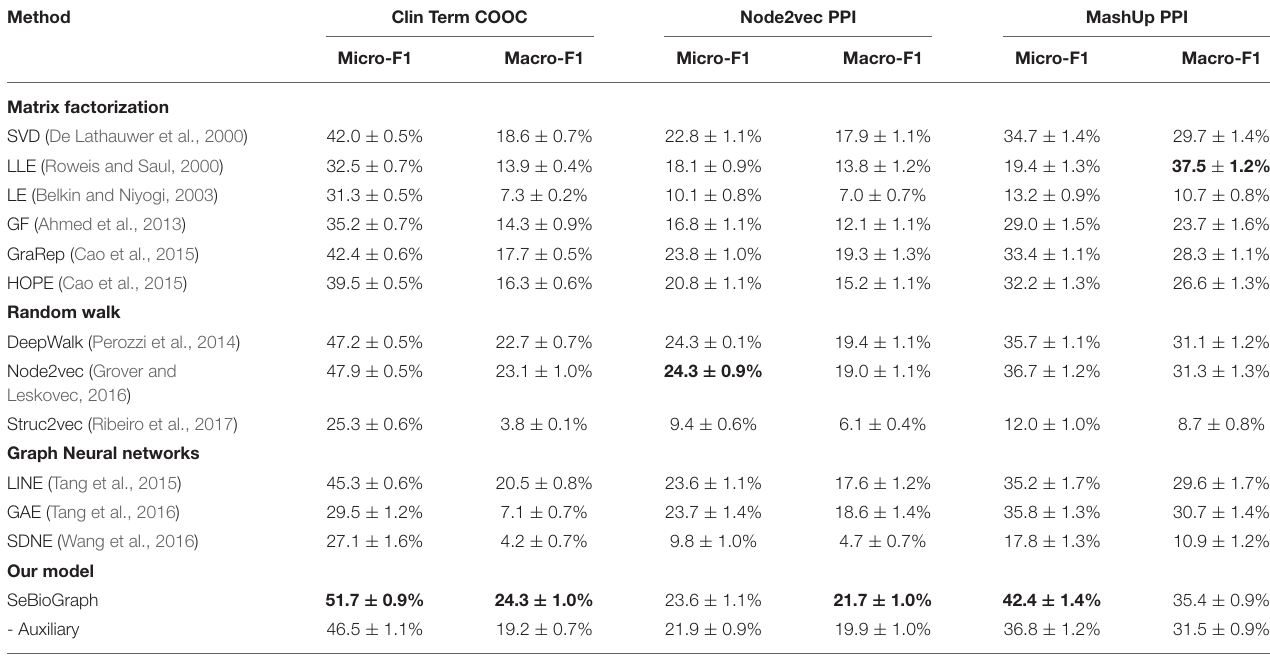
TABLE 2 | Comparison between SeBioGraph and other node classification methods on three biomedical graph datasets.